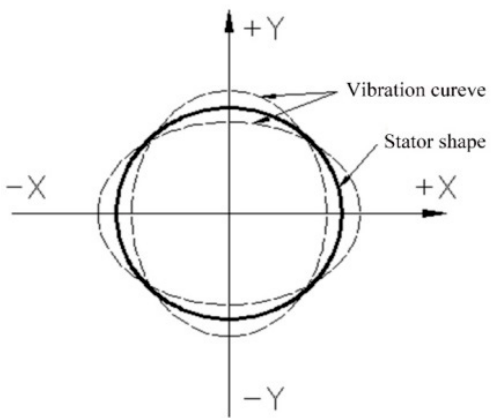
Figure 2. Vibration shape of the tested stator frame.